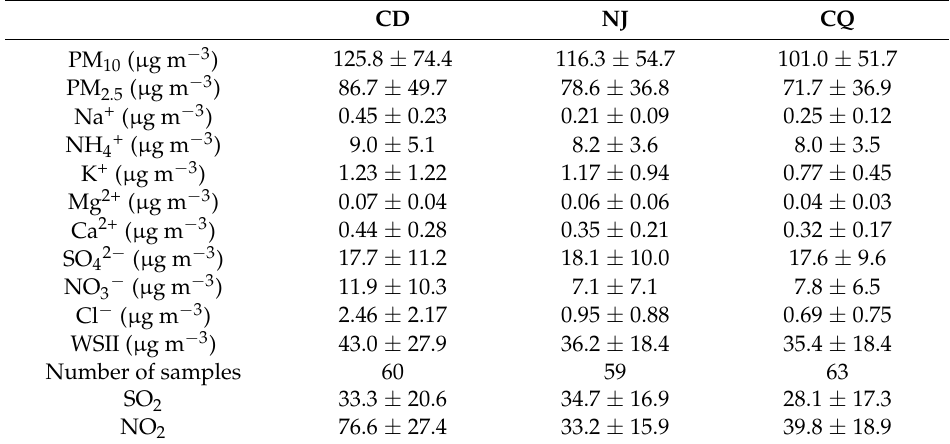
Table 1. Particle and water-soluble inorganic ion (WSII) concentrations in CD, NJ, and CQ